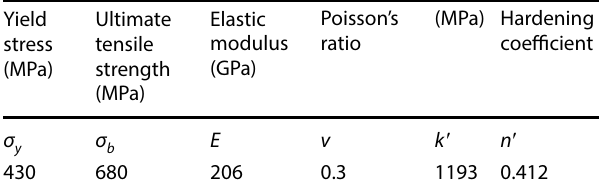
Table 1 Loading conditions of biaxial low-cycle fatigue test